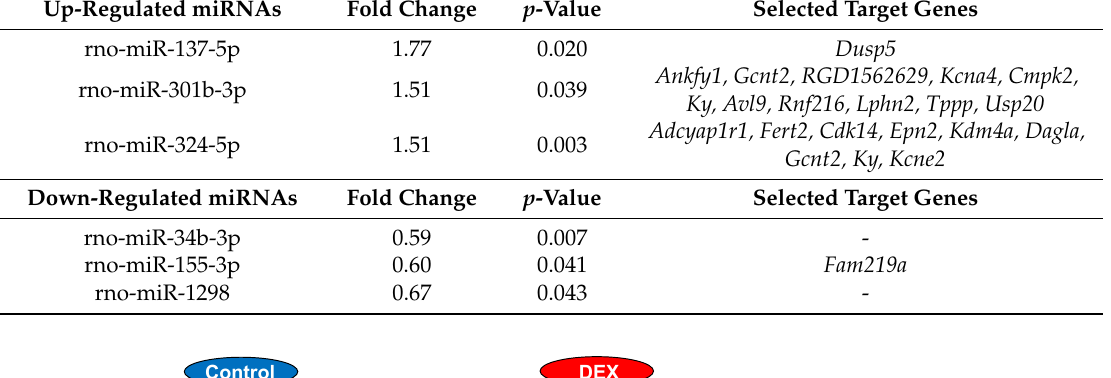
Table 1. Differentially expressed miRNAs and the selected target genes.